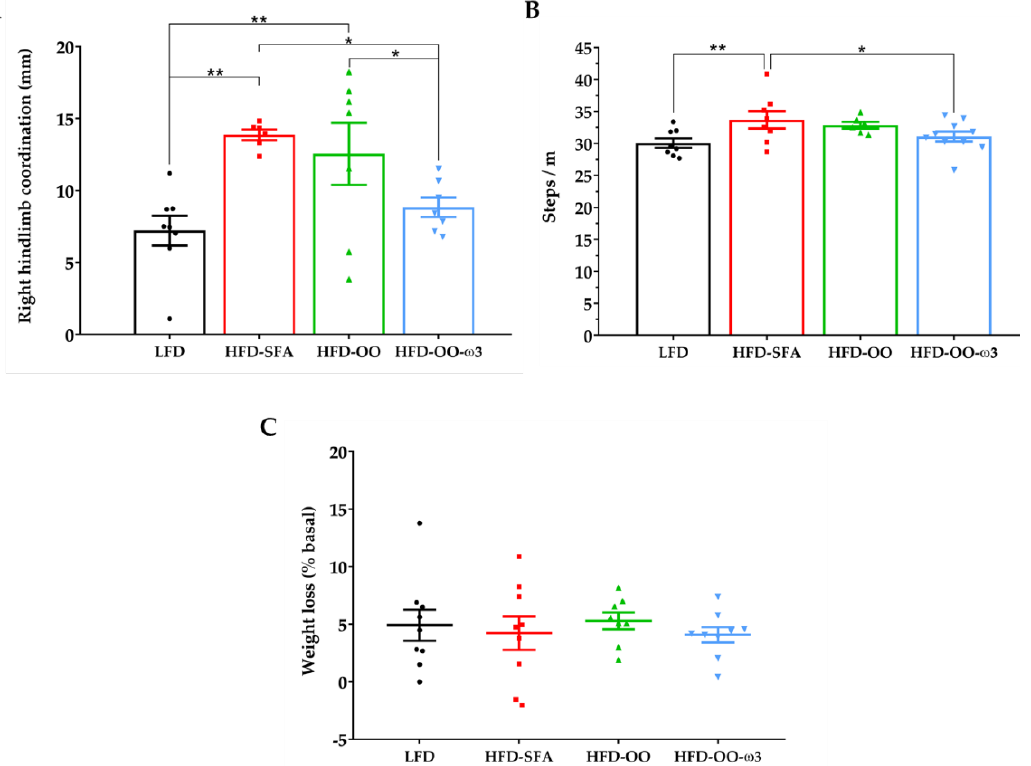
Figure 8. The effect of dietary interventions with a HFD containing a specific fatty acid composition on gait coordination and weight loss. Groups: LFD (Black), HFD-SFA (Red), HFD-OO (Green), and HFD-OO- ω 3 (Blue). ( A ) Mice on a HFD-OO- ω 3 and LFD diet had better coordination of the right hindlimb 48 h after reperfusion than those on a HFD-SFA diet. ( B ) Mice fed with HFD-OO- ω 3 or LFD showed better steps / m values than mice fed a HFD-SFA diet. HFD-OO was not as beneficial as HFD-OO- ω 3 48 h after the onset of reperfusion. ( C ) When the weight loss was analysed 48 h after tMCAo, no significant di ff erences were found between the groups. The results represent the mean ± SEM of 6 to 10 mice: * p ≤ 0.05 and ** p ≤ 0.01 (ANOVA + Bonferroni post-hoc). Low-fat diet ( LFD ), high-fat diet rich in saturated fatty acids ( HFD-SFA ), high-fat diet rich in olive oil ( HFD-OO ), and high-fat diet rich in olive oil plus DHA and EPA ( HFD-OO- ω 3 ) .